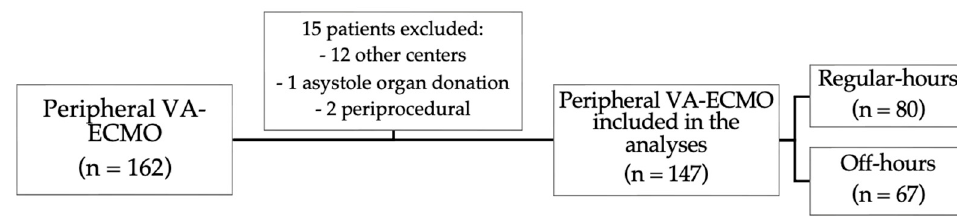
Figure 1. Flow chart. VA-ECMO: venoarterial extracorporeal membrane oxygenation.